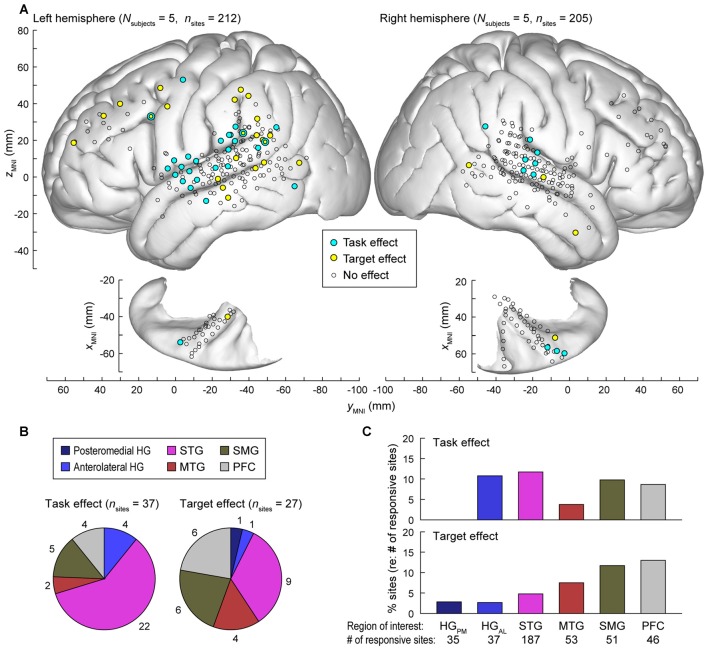
Summary of task and target effects across the nine subjects. (A) Spatial distribution of task and target effects (blue and yellow symbols, respectively). Data from all subjects (212 sites in the left hemisphere and 205 sites in the right hemisphere; left and right panels, respectively) are plotted in Montreal Neurological Institute (MNI) coordinate space and projected onto FreeSurfer average template brain. Open symbols indicate sites within the regions of interest that exhibited significant high gamma responses to the word stimuli (see “Materials and Methods” Section), but did not exhibit either task or target effect at p = 0.05 significance level (false discovery rate (FDR)-corrected). (B) Distribution and number of sites exhibiting significant task and target effects (left and right pie chart, respectively) across regions of interest. (C) Percentage of responsive sites that exhibited significant task and target effects (top and bottom graph, respectively) within each region of interest. HGPM, posteromedial HG; HGAL, anterolateral HG.